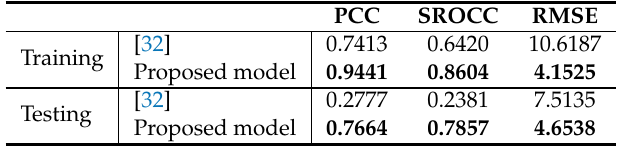
Table 3. Prediction performance of the reference model and our proposed model over training and testing